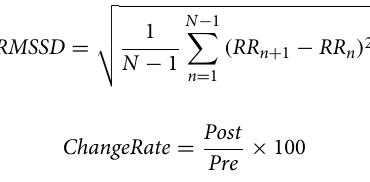
Figure 1. Experiment design and process of signal recording and analysis. EGG, electrogastrogram; DF, dominant frequency; HRV, heart rate eight wave peaks were obtained. The frequency corresponding to the maximum wave peak value represented the DF of each subject. Root mean square of successive differences (RMSSD) and mean RR interval analysis. The analysis method can be referenced in previous study 29 . The raw data of 1 channel was exported in European data format (EDF) format, imported into Kubio HRV software (Kubios Oy, Kuopio, Finland) and analyzed 30–32 . The data were detrended using the smoothness prior approach with a lambda value of 500 and artifacts were cor- rected by applying the medium filter provided by Kubios HRV. RMSSDwas calculated by (1). Both the mean RR and RMSSD change rates were calculated by (2).